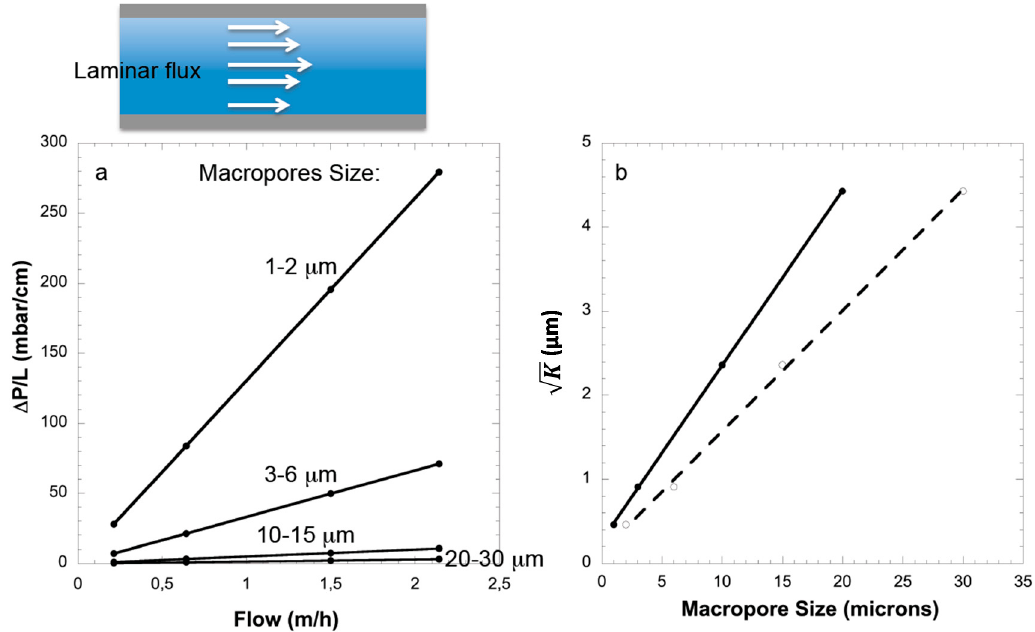
Figure 3. ( a ) Pressure drop as a function of linear velocity and macropore diameter of hierarchical silica monoliths; ( b ) square root of permeability ( K ) of the hierarchical silica monoliths as a function of macropore diameter (minimum diameter (plain line), maximum diameter (dashed line)).